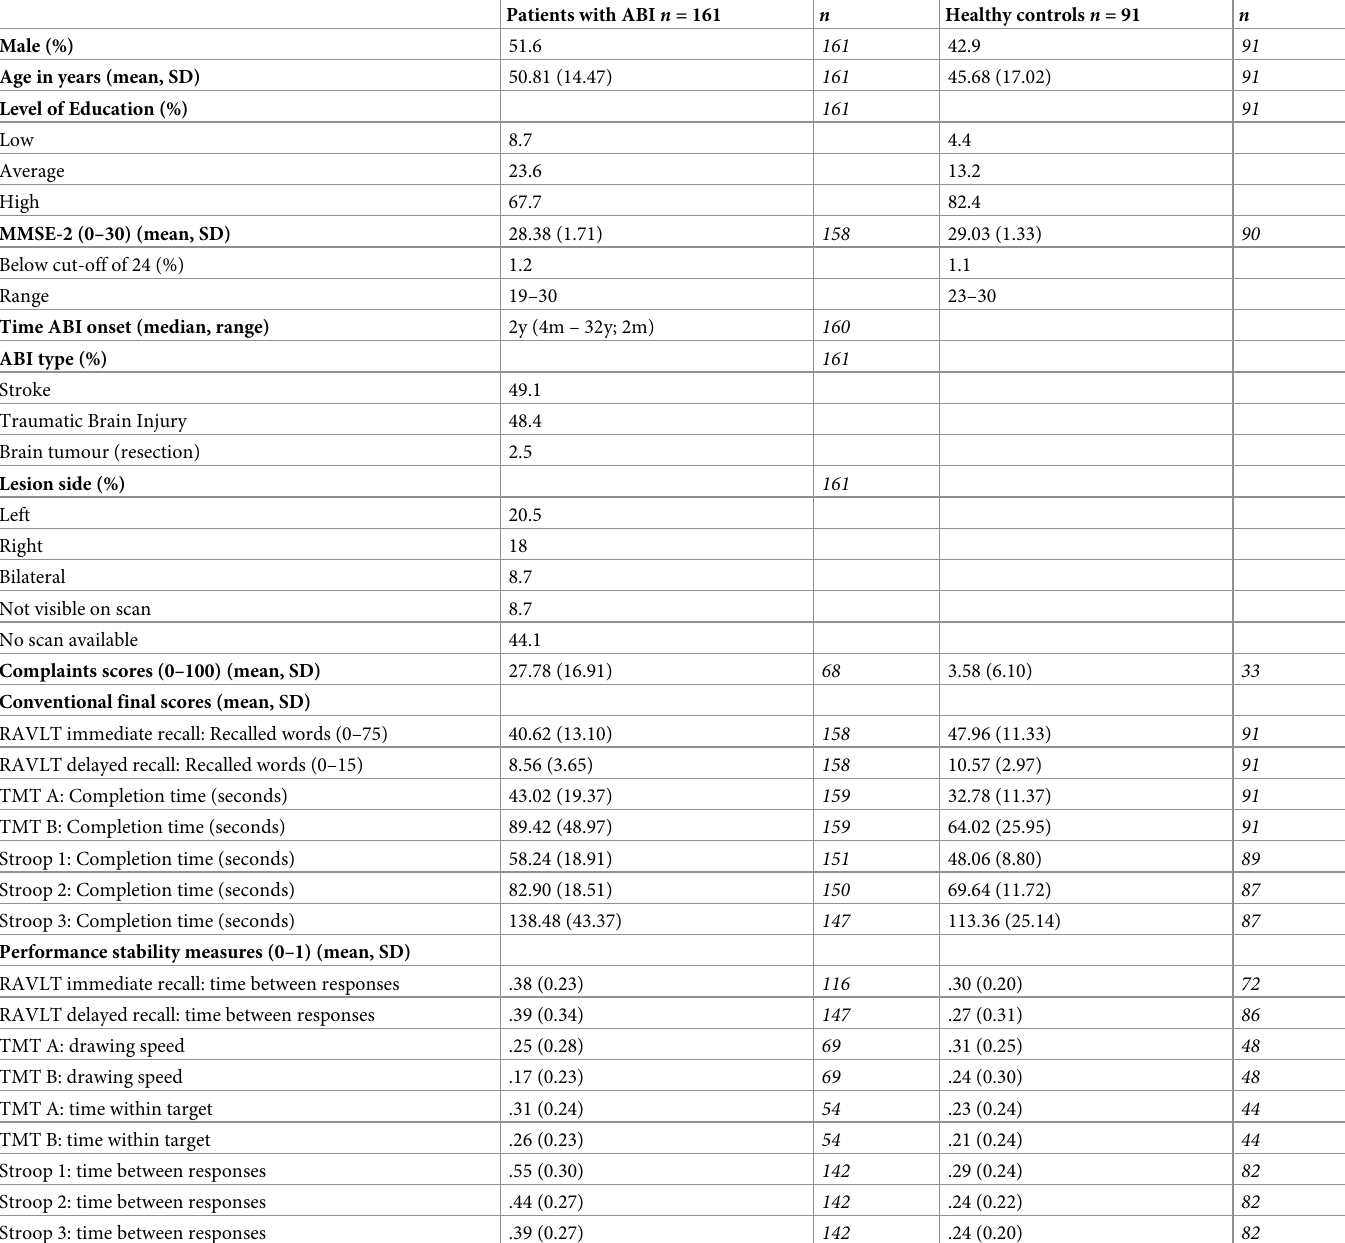
Table 1. Demographical and clinical characteristics, split for patients and healthy controls.